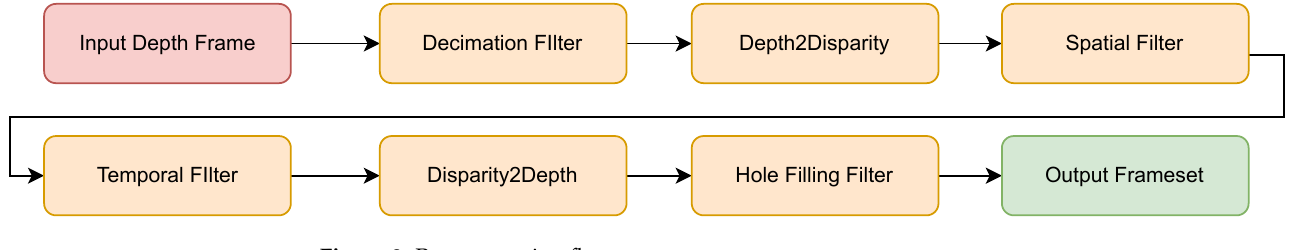
Figure 3. Postprocessing